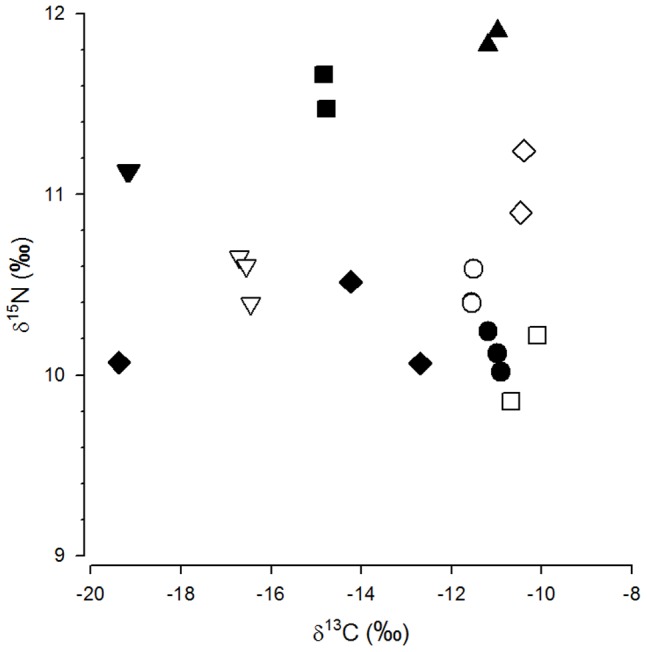
Nitrogen isotope ratios (δ15N; ‰) in relation to stable carbon isotope ratios (δ13C; ‰) in cheetah groups of bachelor males.Each symbol represents one individual. Groups are indicated by different symbols.